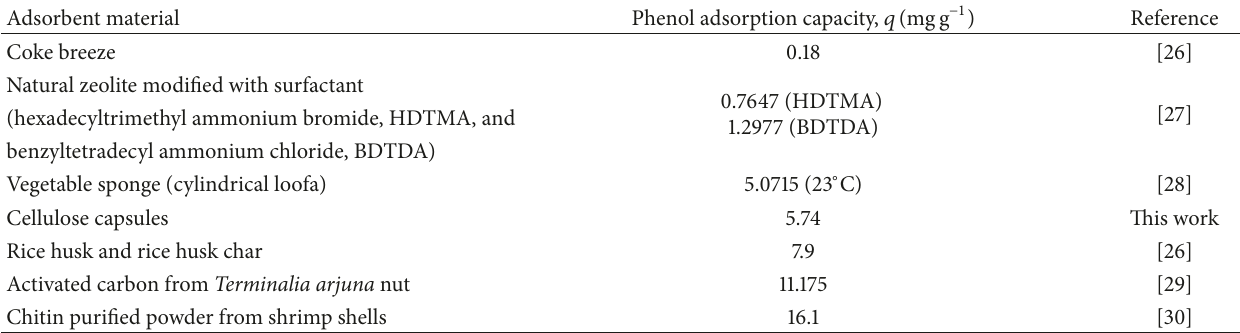
Adsorbent material